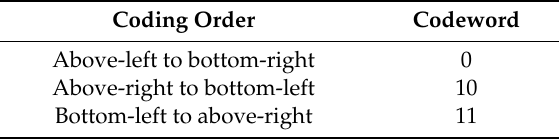
Table 1. Codeword for the three di ff erent coding order.